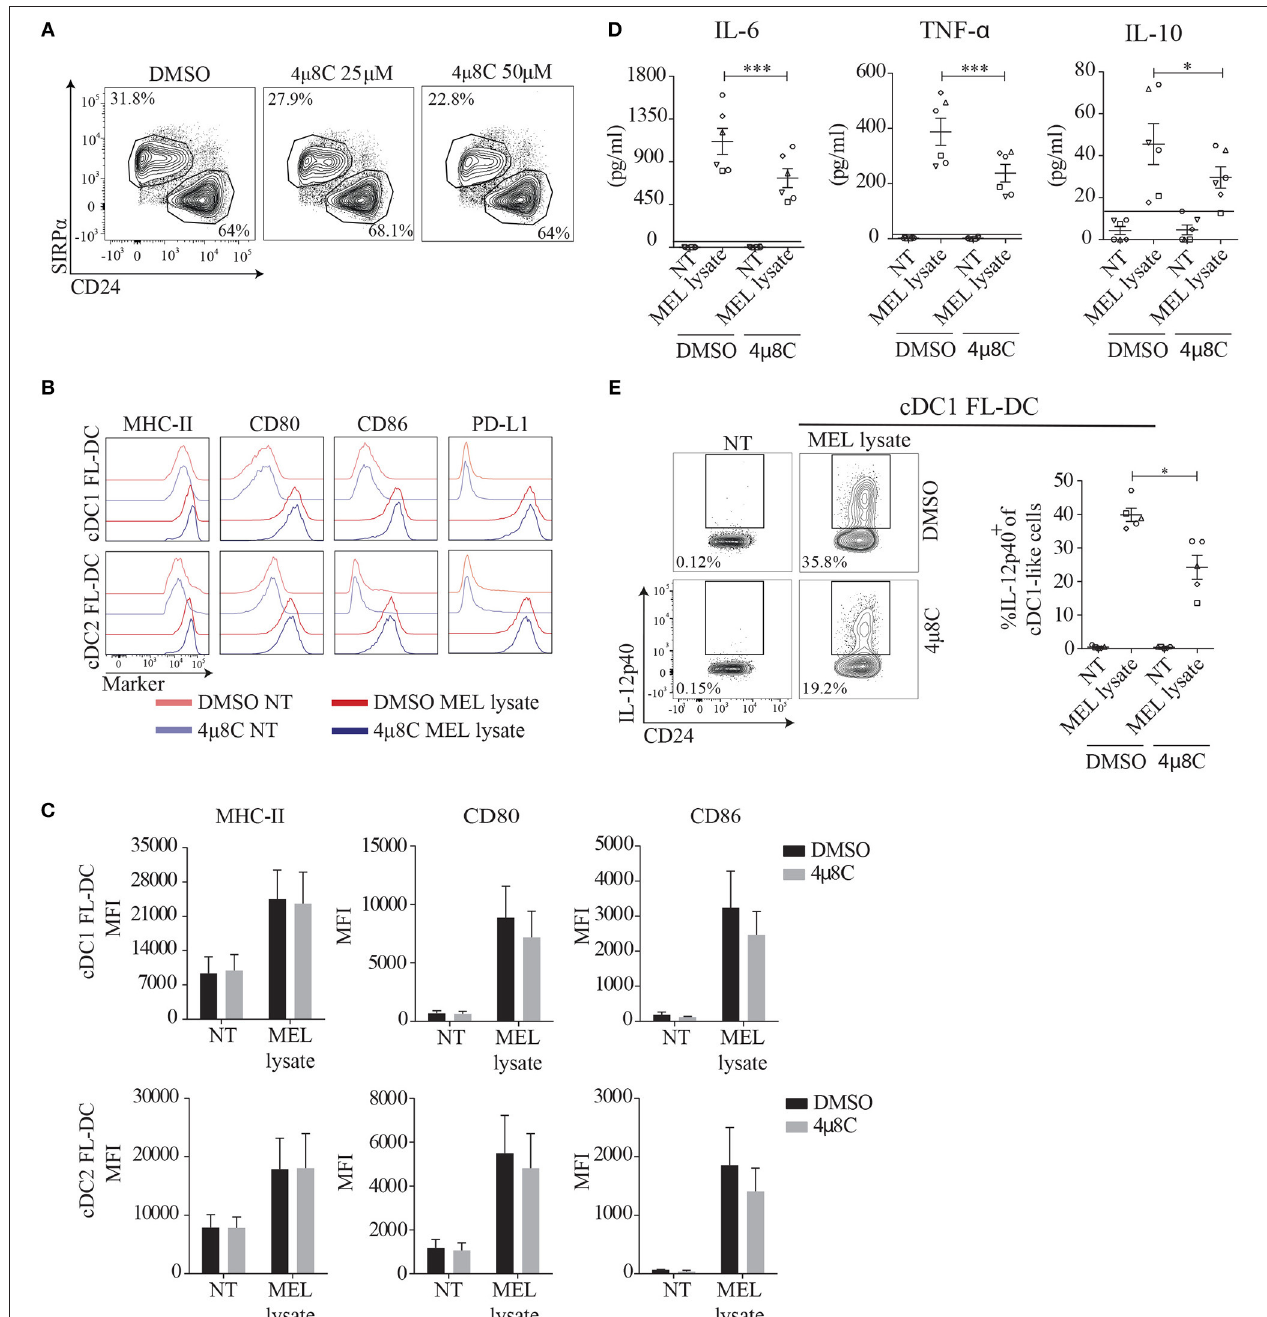
FIGURE 3 | Inhibition of the IRE1 α endonuclease domain by the aldehyde 4 µ 8C does not affect BMDC cellularity or expression of costimulatory molecules, but reduces the production of cytokines upon MEL stimulation. (A) FL-DCs were stimulated with increasing doses of 4 µ 8C or DMSO and composition of DC subtypes was monitored 24h post treatment. (B,C) FL-DCs were pretreated with 20 µ M 4 µ 8C or DMSO for 2h and stimulated with 100 µ g/ml MEL for additional 16h. Expression of MHC-II, CD80, CD86, and PD-L1 were measured by flow cytometry. Histograms shown in (B) are one representative experiment out of five of cDC1 FL-DC (CD24 + ) and cDC2 FL-DC (SIPR α + ) generated in cultures and graphed in (C) . (D) FL-DCs were pretreated with 20 µ M 4 µ 8C or DMSO for 5h and stimulated with 100 µ g/ml MEL for additional 16h. TNF- α , IL-6, and IL-10 were quantified by cytometric bead array. (E) FL-DCs were pretreated with 50 µ M 4 µ 8C or DMSO for 5h and stimulated with 100 µ g/ml MEL for additional 16h. IL-12p40 was analyzed by intracellular staining. Contour plots and graphs are for cDC1 FL-DC (CD24 + ) generated in cultures. For (D,E) , each symbol in the graphs represents data derived from one independent experiment. For all error bars represent mean ± SEM. * p < 0.05, *** p < 0.001 (paired Student’s t